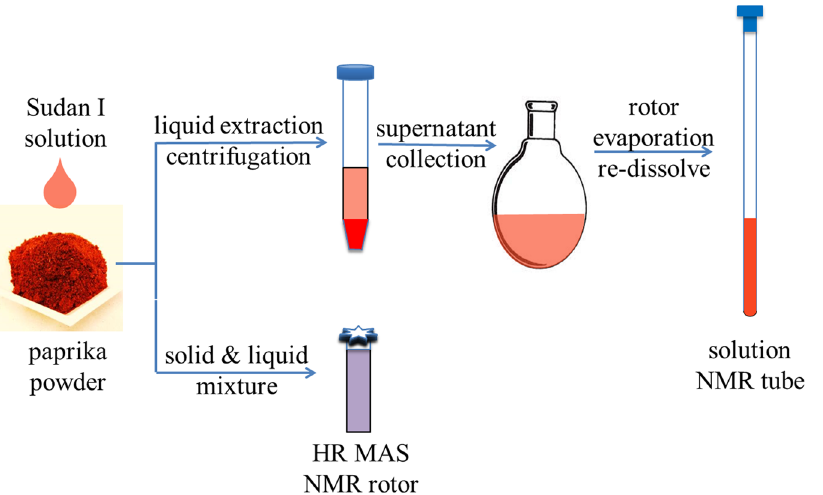
Figure 2. Schematic illustration of experimental design. NMR, nuclear magnetic resonance; HR MAS, high resolution magic angle